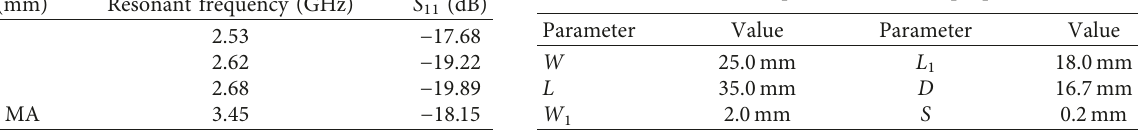
Figure 4: The simulated S 11 varies with D. Table 2: Geometric parameters of the proposed